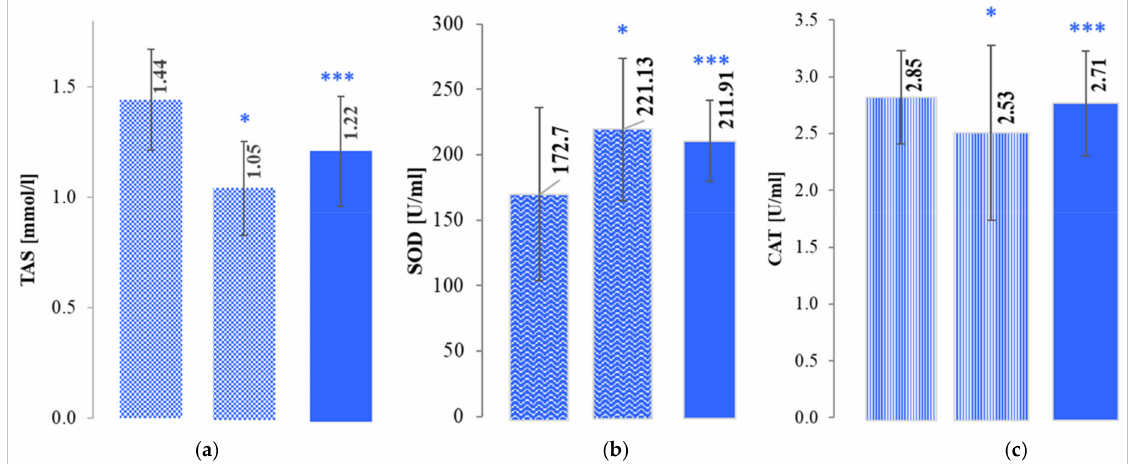
Figure 13. The activity of ( a ) TAS, ( b ) SOD and ( c ) CAT in the control group, the post-chemotherapy group (*) and the post-chemotherapy group with the copper(II) complex 1 (***).